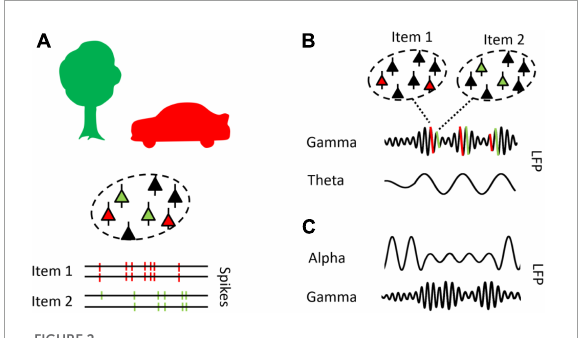
FIGURE2 Theta, alpha, and gamma oscillations reflect distinct neural mechanisms. (A) Neurons which encode the same object (i.e., item) synchronize firing activity within and across cell assemblies in a gamma pace ( > 30 Hz) (cf., Gray et al., 1989). (B) The theta rhythm (3–8 Hz) is presumed to organize neural processes, as reflected in a theta-gamma neural code, a coding schema proposed to serve the segregation and ordering of neural representations (cf., Lisman and Jensen, 2013). (C) Alpha (8–14 Hz) oscillations by act as a gating mechanism, inhibiting neural processes in task irrelevant networks and facilitate information processing in task relevant networks, such that reduced alpha power coincides with increased gamma power (cf., Jensen and Mazaheri,